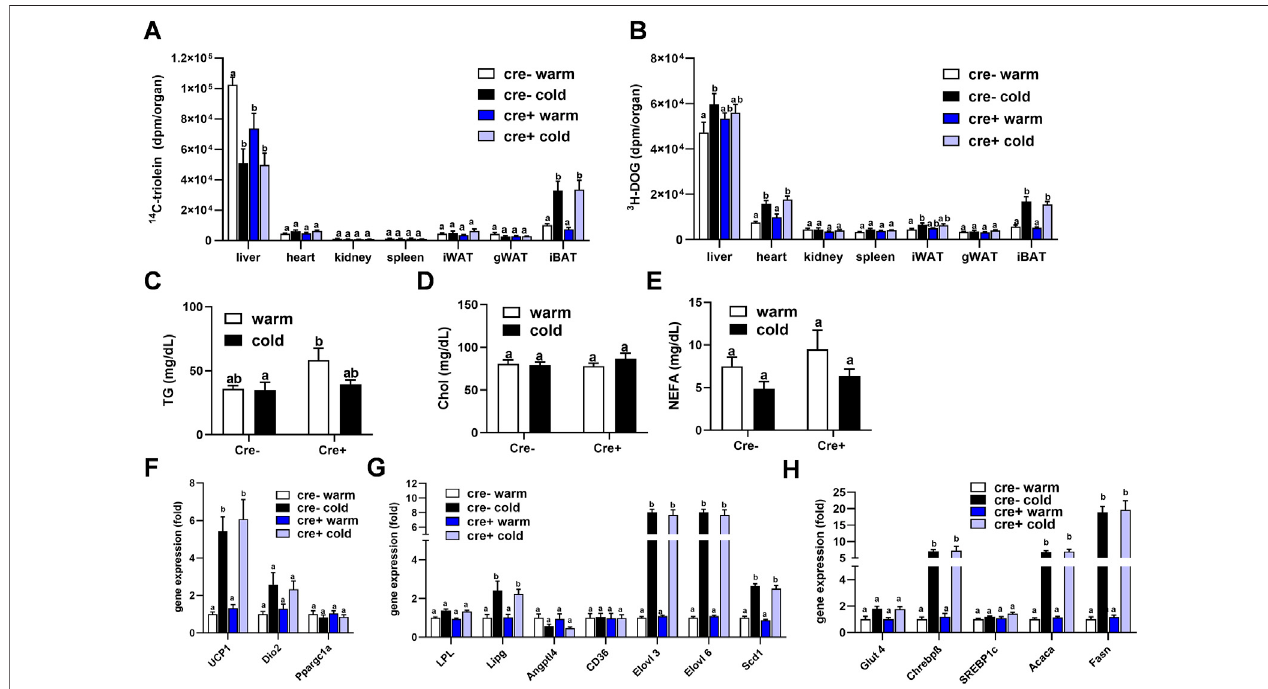
FIGURE 4 | Organ lipid and glucose uptake and BAT gene expression in the postprandial state. EndoLPLko (Cre+) mice and Cre-litter mates (n = 6) were fed a western-typedietfor2weeks,andhousedat6 ° C(cold)or30 ° C(warm)inthesecondweek.Organandplasmaharvestwasperformed2 hafteracombinedoralglucose and fat gavage. (A) Organ uptake of 14 C-Triolein and (B) 3 H-deoxyglucose( 3 H-DOG). Plasma levelsof (C) triglycerides, (D) cholesterol and (E) Non-esteri fi ed fatty acids (NEFA). Expression of (F) thermogenic, (G) lipoprotein and lipid-handling, and (H) glucose-handling genes in BAT of EndoLPLko mice. Results are presented as meanvalues±SEM.Statisticalsigni fi cancewasdeterminedbytwo-wayANOVA( p < 0.05).Sameletterdenotesgroupsthatarenotsigni fi cantlydifferentfromeachother ( p ≥